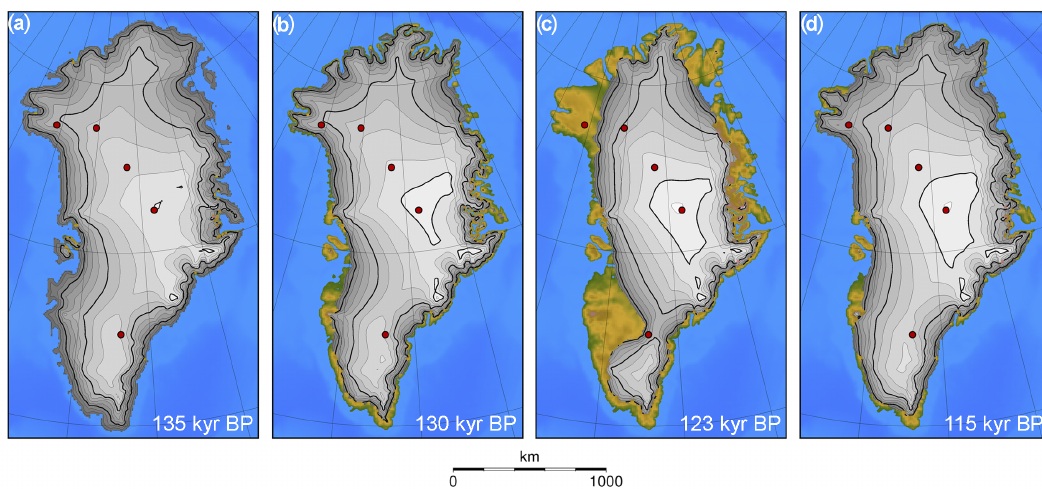
Figure 5. Greenland ice sheet geometry at 135kyrBP (a) , at 130kyrBP (b) , for the minimum ice sheet volume at 123kyrBP with a sea-level contribution of 1.4m (c) , and at the end of the reference experiment at 115kyrBP (d) . The red dots indicate the deep ice core locations (from south to north-west: Dye-3, GRIP, NGRIP, NEEM, Camp Century).